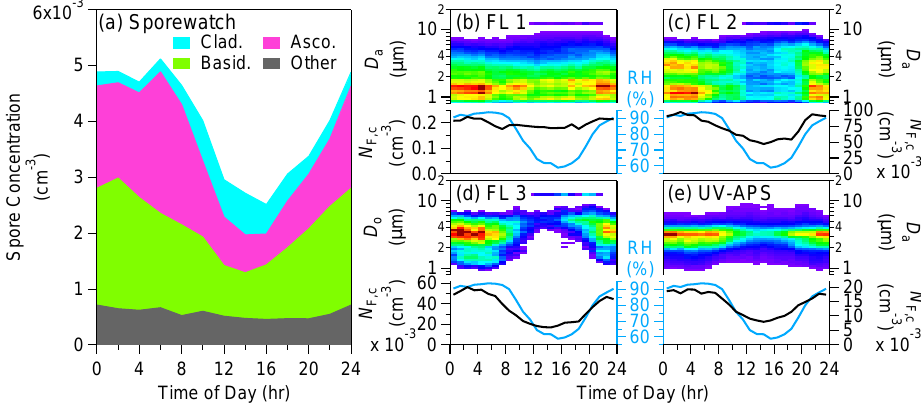
Figure 7. Diurnal plots of number concentrations from Sporewatch (a) and real-time fluorescence instruments (b–e) as median values for entire sampling period. For panels (b–e) , upper half of each panel shows size-resolved number concentration trends, with color scale qualitatively similar to Fig. 2 (warmer colors, higher concentration). Lower half of each panel shows integrated fluorescent particle number ( N F , c , D >1µm) as the black trace and relative humidity as the blue trace. Vertical scale on N F , c axes not consistent. N F , c scale for (c–e) shown expanded by 10 3